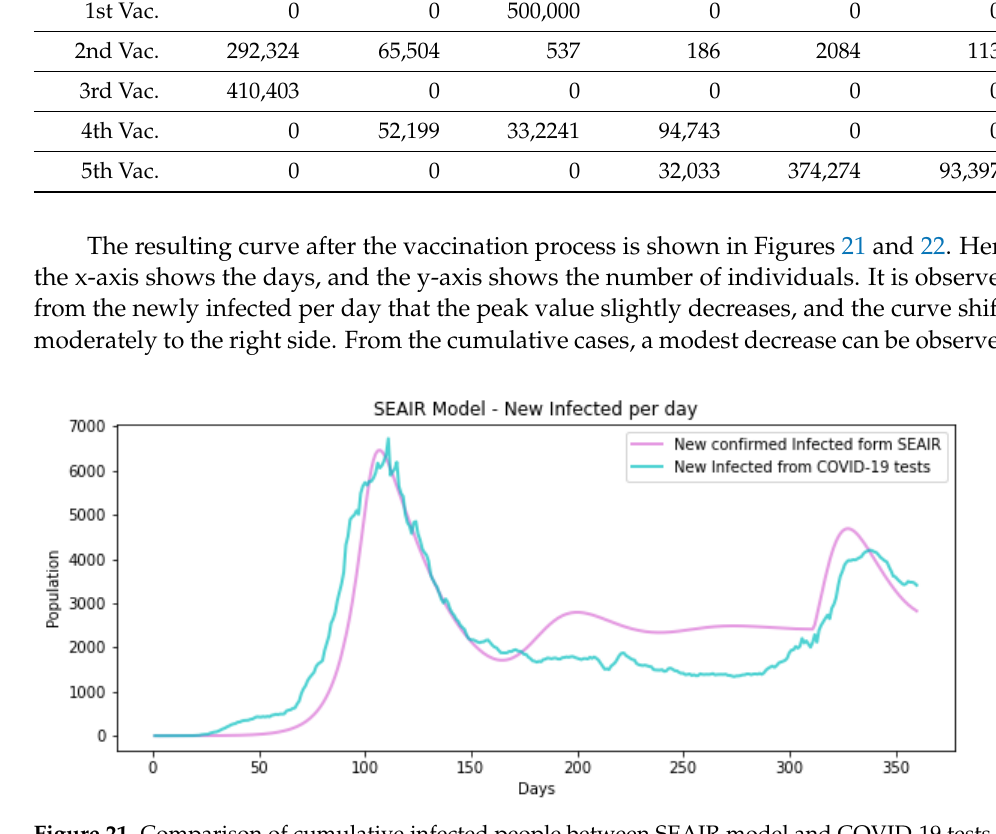
Figure 21. Comparison of cumulative infected people between SEAIR model and COVID-19 tests in Chile’s second wave after applying the best vaccination plan found.